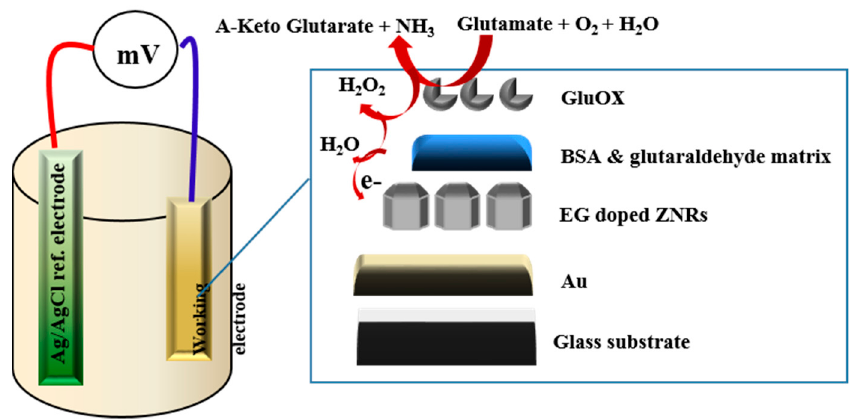
Scheme 2. Represents the potentiometric measurements; working electrode and charge environment